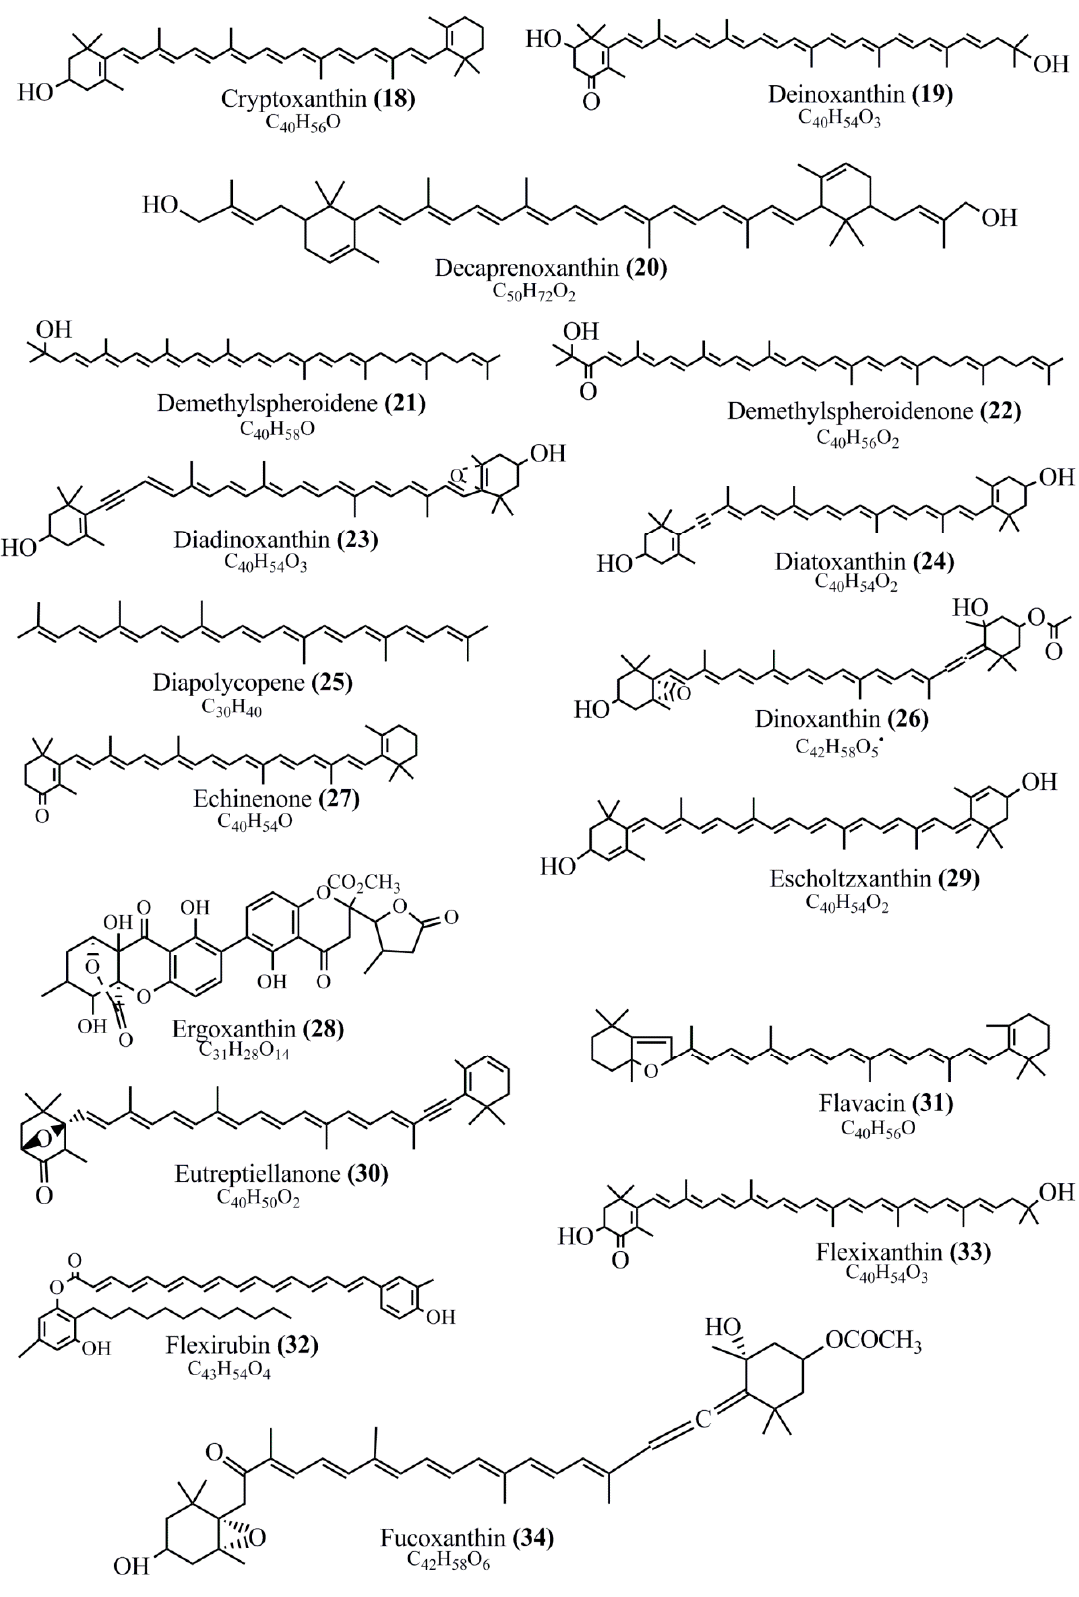
Figure 1. Continued. Figure 1.